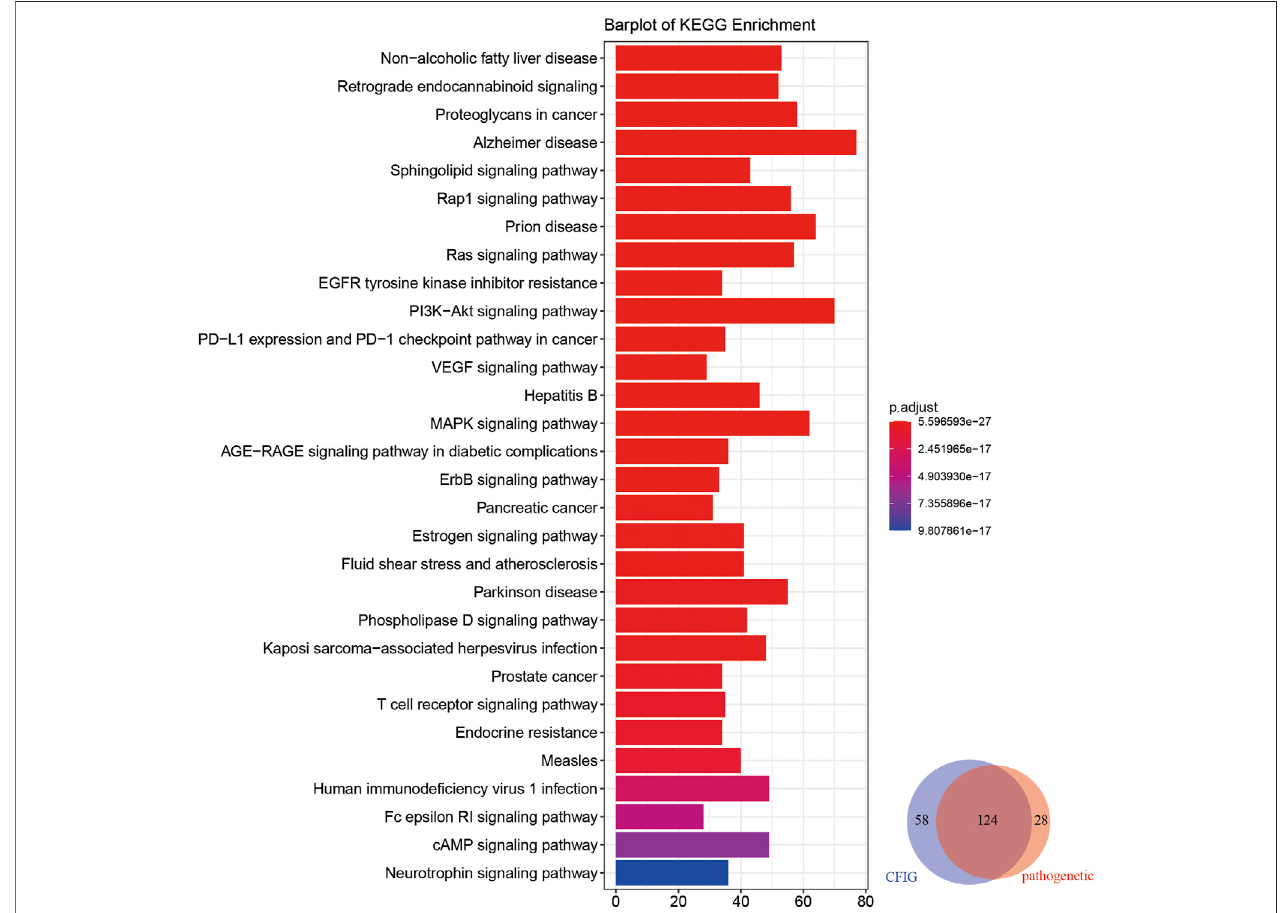
FIGURE 8 | KEGG enrichment analyses of the targets of the CFIG. The color change represents the signi fi cance of the enrichment of genes.